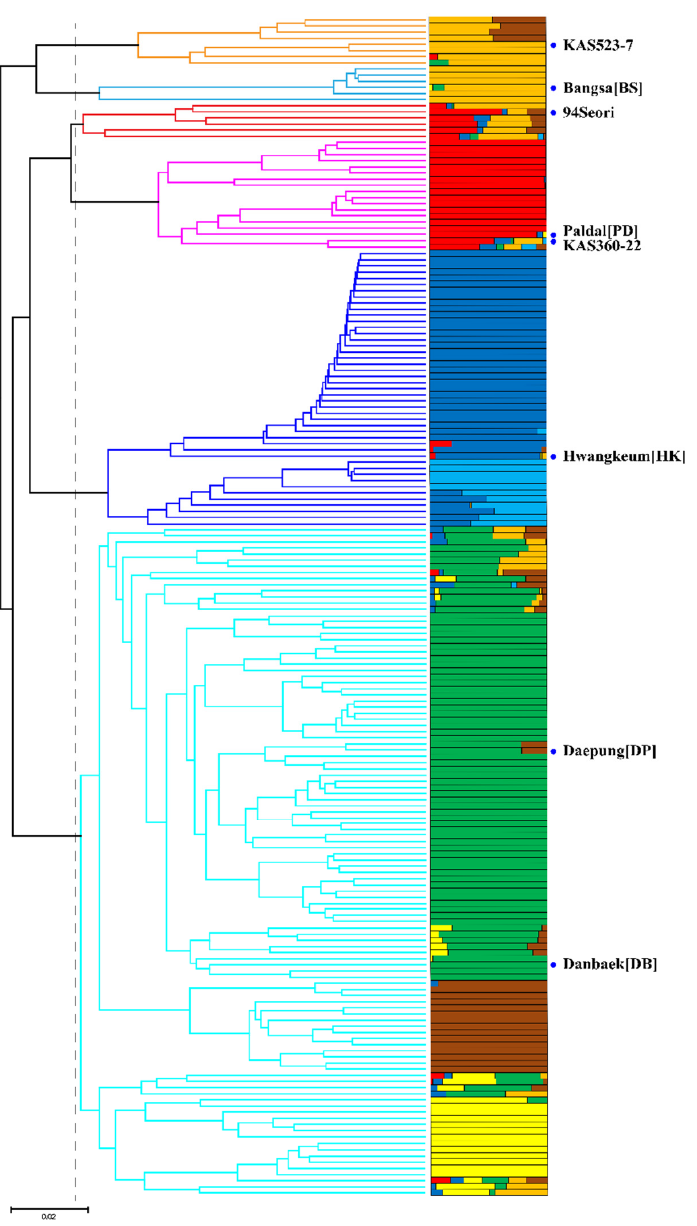
Figure 1. Genetic diversity and population structure of 192 soybean MDP lines. In the bar plot illustrating the population structure, each individual is represented by a single horizontal bar, with different colors used to represent different subpopulations.